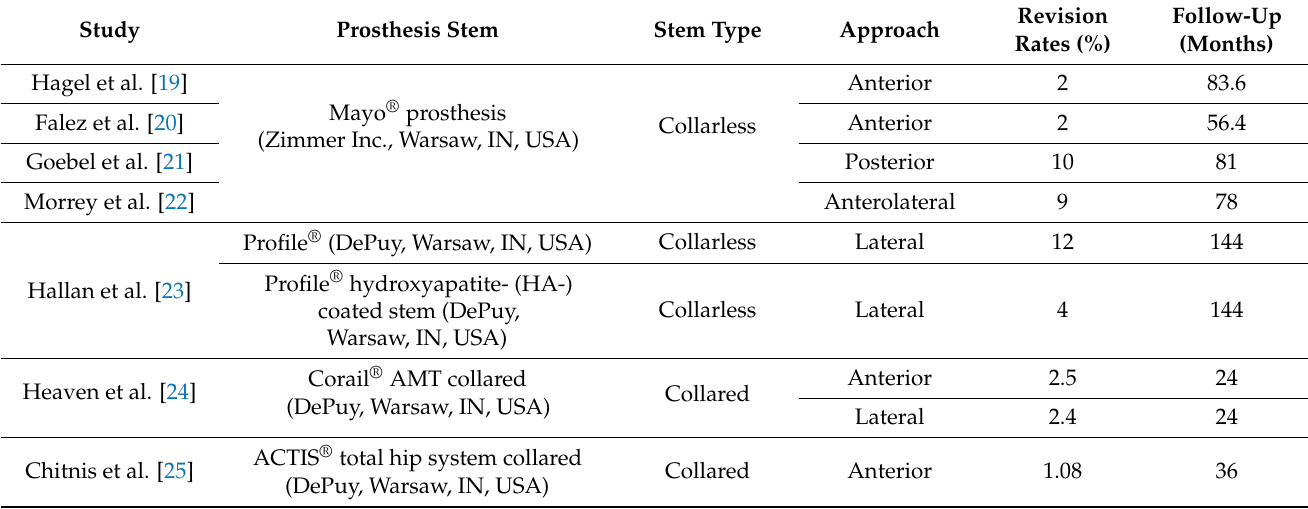
Table 4. Revision rates of other hip prosthesis